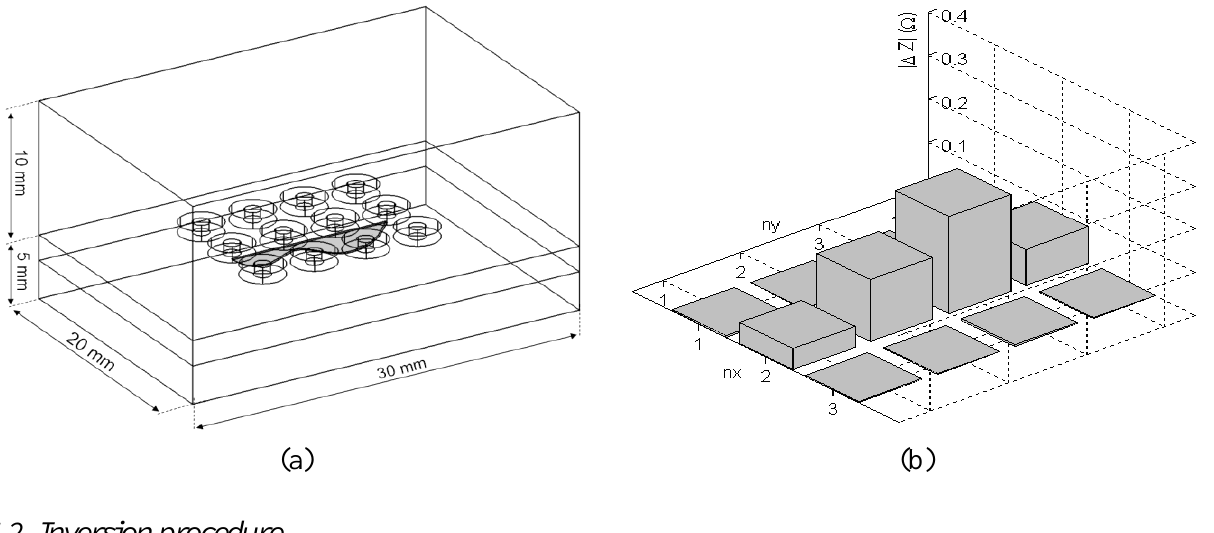
Figure 6. Example of a crack shape defined by the discrete values q